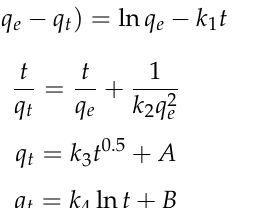
Figure 7. The adsorption performance under different contact time.